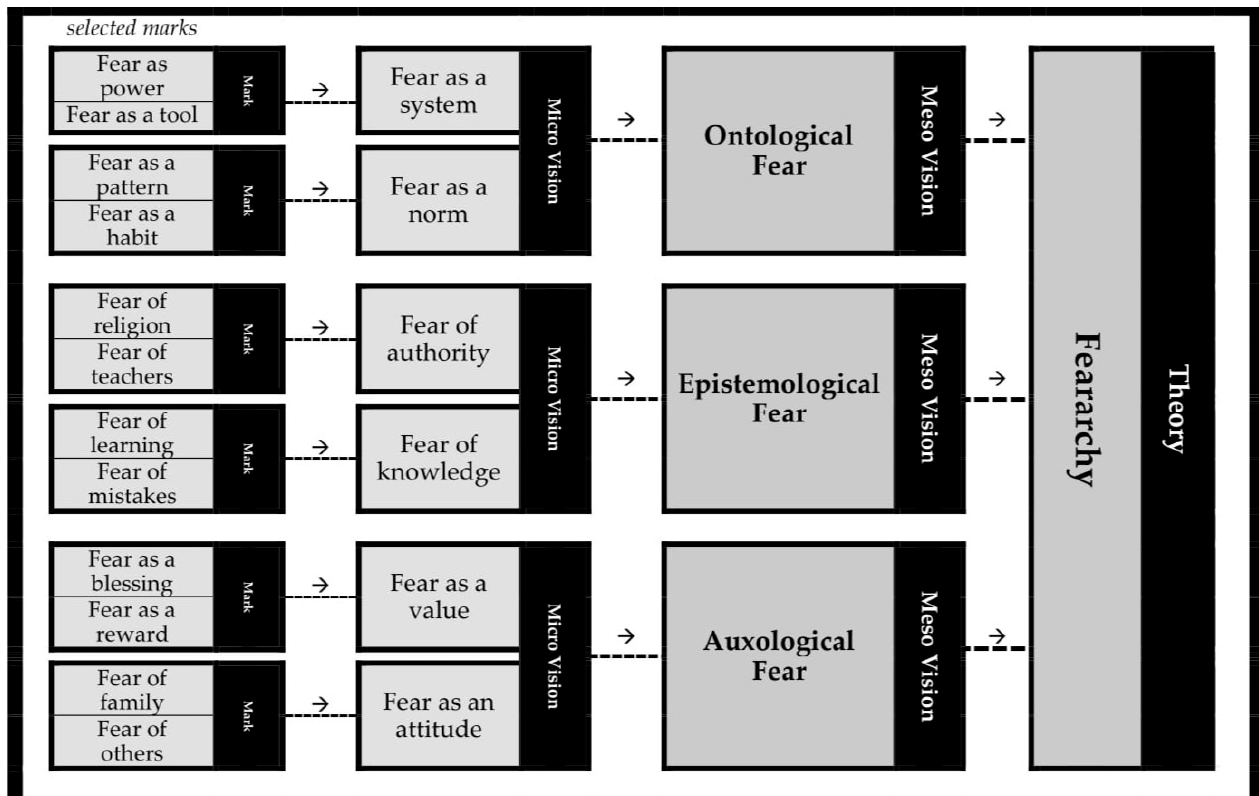
Figure 1. Data Analysis.